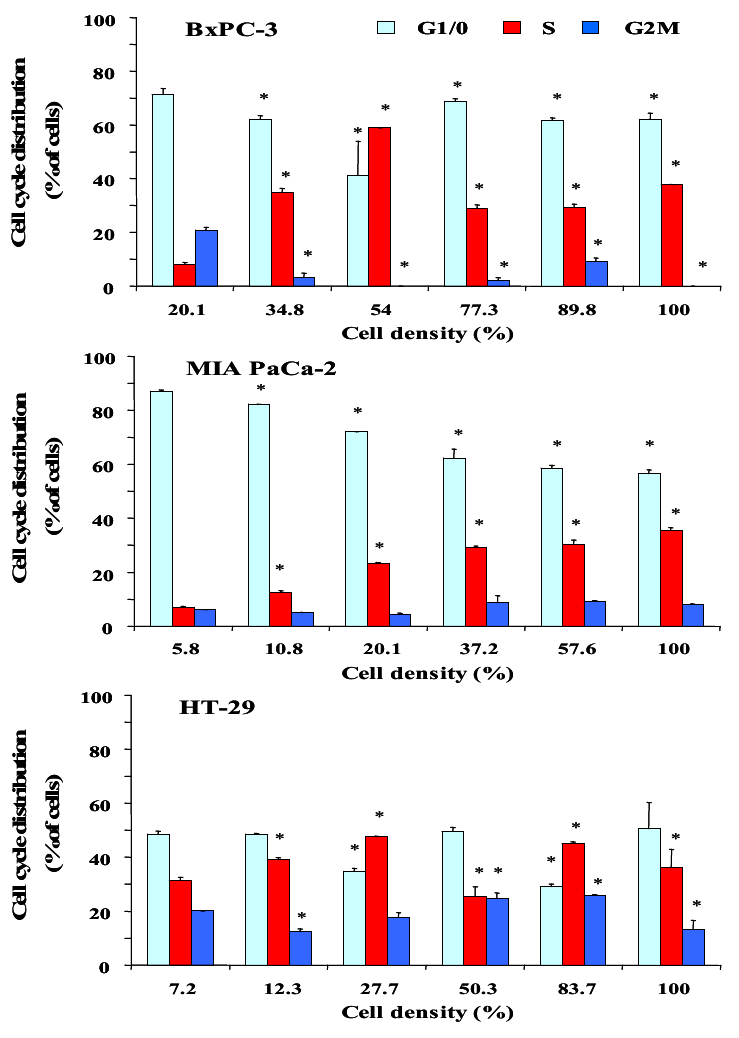
Figure 2. Dependence of the cell cycle distribution of BxPC-3 (top), MIA PaCa-2 (middle) and HT-29 (bottom) cells on the cell layer density. Data are presented as mean ± SD of duplicate measurements (differences in cell cycle phases to lowest density: * p <